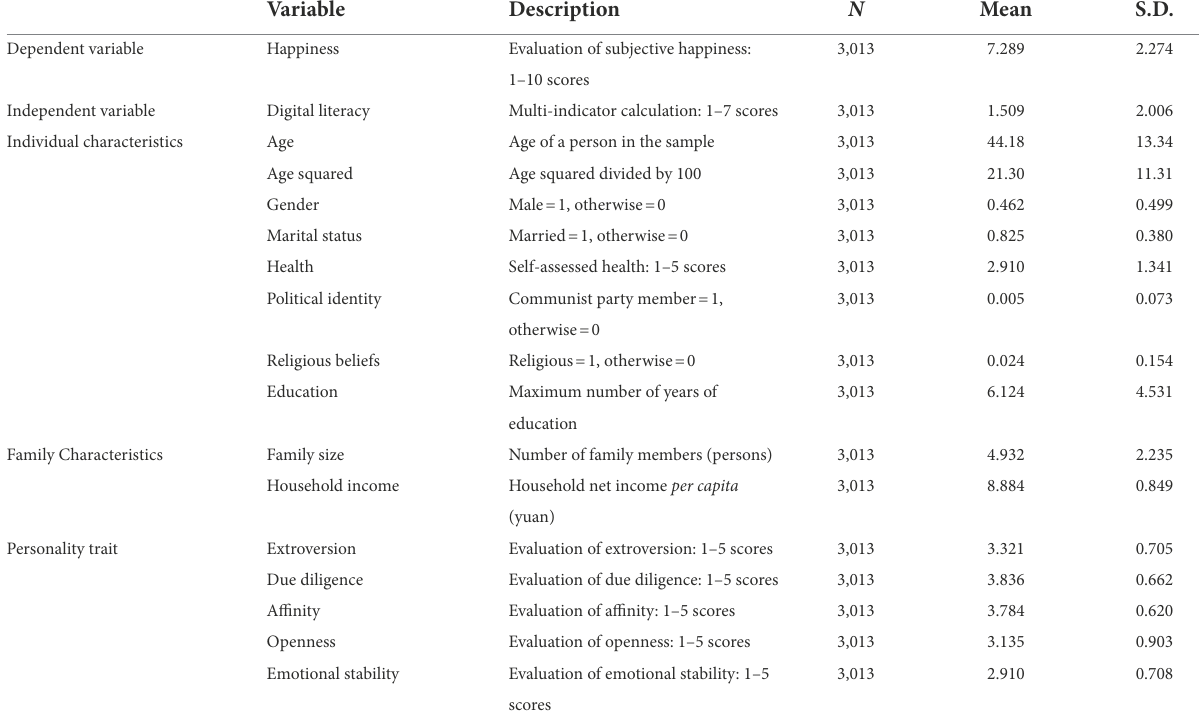
TABLE 1 Summary